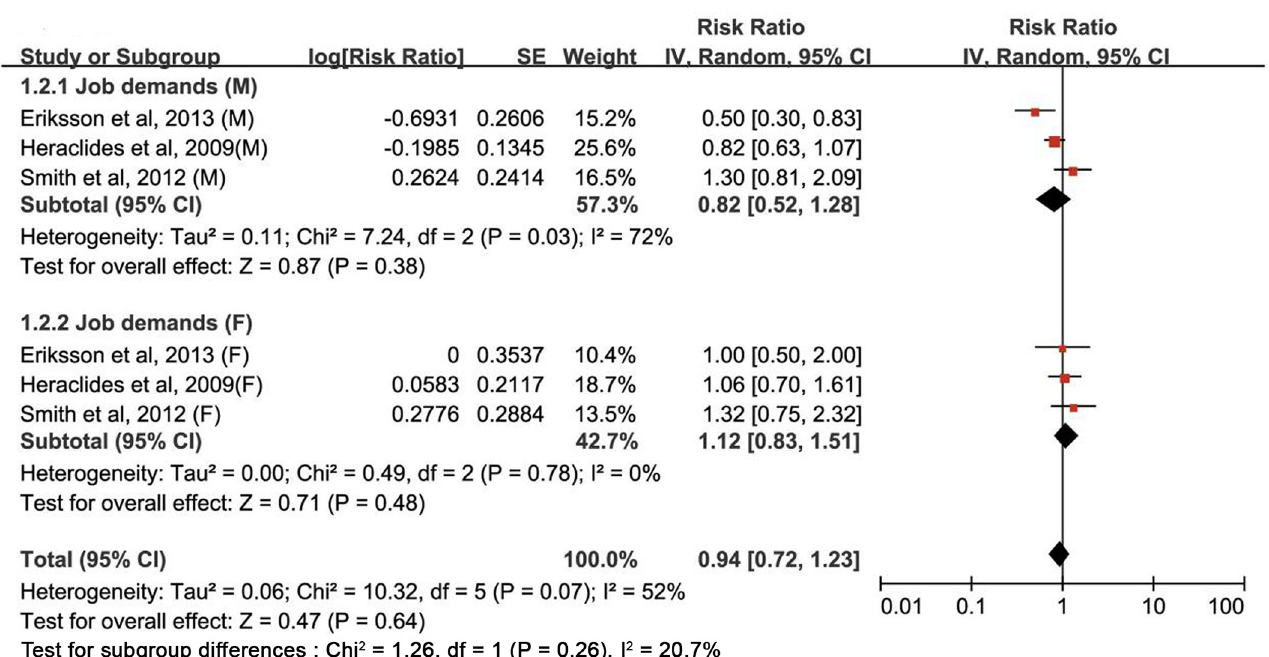
Fig 3. Estimates of type 2 diabetes associated with job demands in men and women. SE, standard error; CI, confidence interval; M, male; F, female.